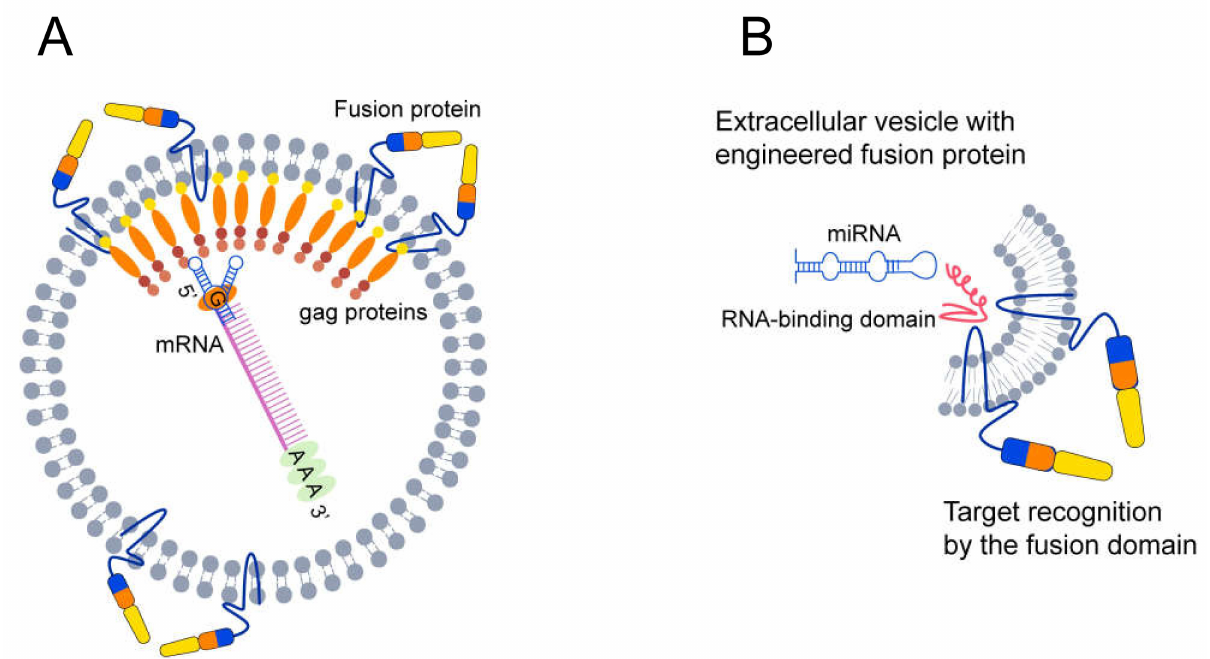
Figure 2. EVs functionalized with fusion proteins. ( A ) Design of a system for sorting mRNA into EVs using viral gag protein and the packing signal. The gag protein selectively binds the packaging signal and saturates the vesicles with mRNA. ( B ) The EV vector may be functionalized with an engineered fusion protein (shown in multicolor monomers) that contains an RNA binding domain (shown in red). The intravesicular domain of fusion proteins consists of an RNA-binding domain (RBD) that can bind specific miRNAs with the packaging signal. The RNA packaging signal is recognized by the RBD of fusion proteins and may stimulate the upload of miRNA into EVs. Fusion proteins may interact with an extravesicular recognition domain and form the structure required for merging with the target